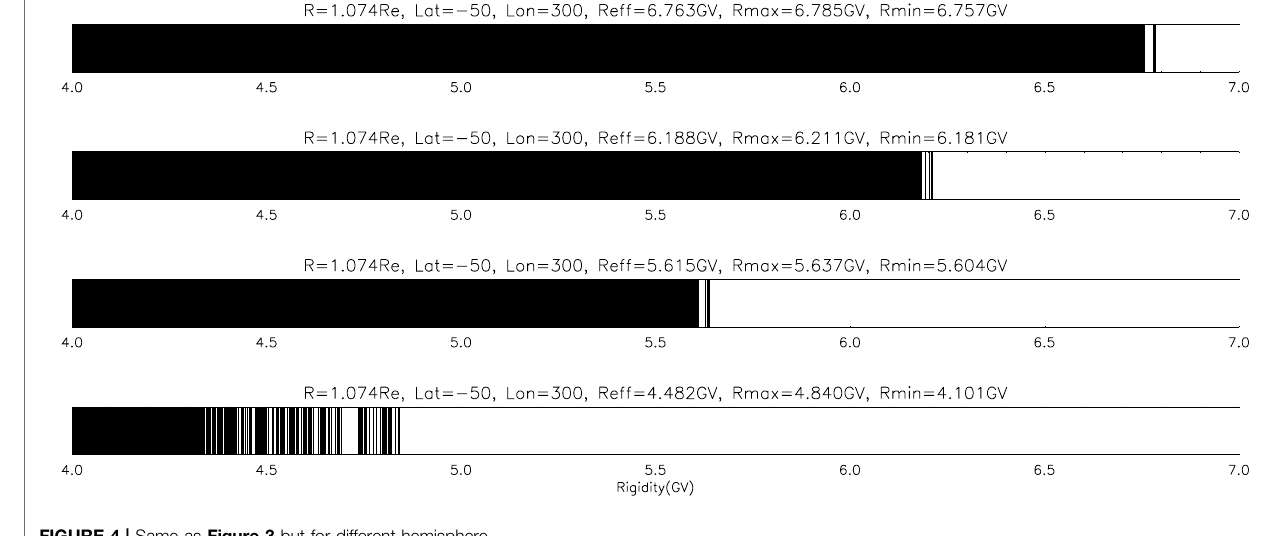
FIGURE 4 | Same as Figure 3 but for different